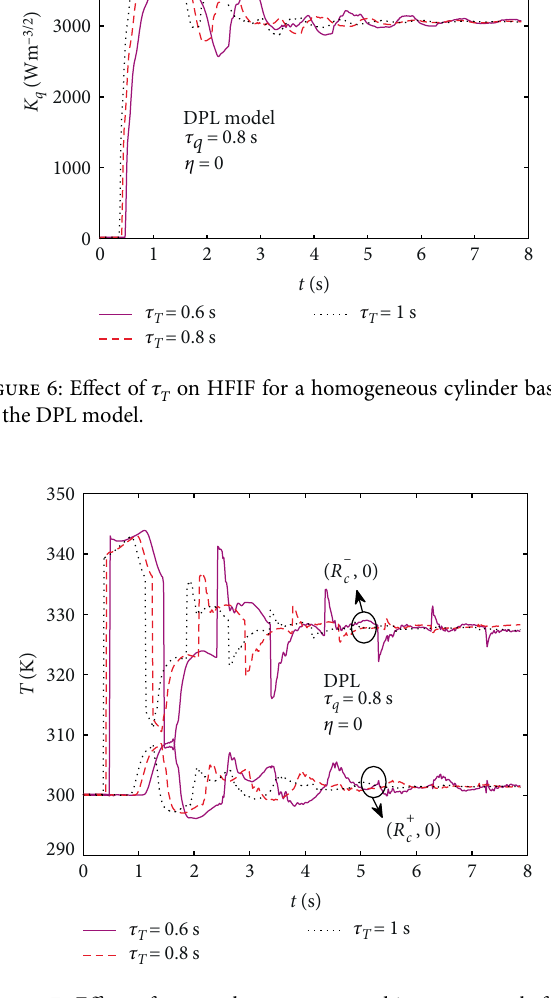
Figure 5: Effect of on the temperature history at crack face 𝜏 𝑞 midpoints for a homogeneous cylinder based on the C–V model.